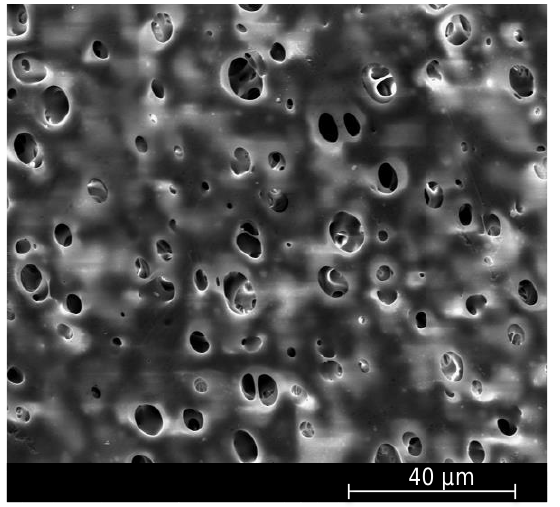
Figure 3. SEM image of the used polyether sulfone membrane (upstream side). Table 1. Characteristic properties of the filter media for cake filtration.